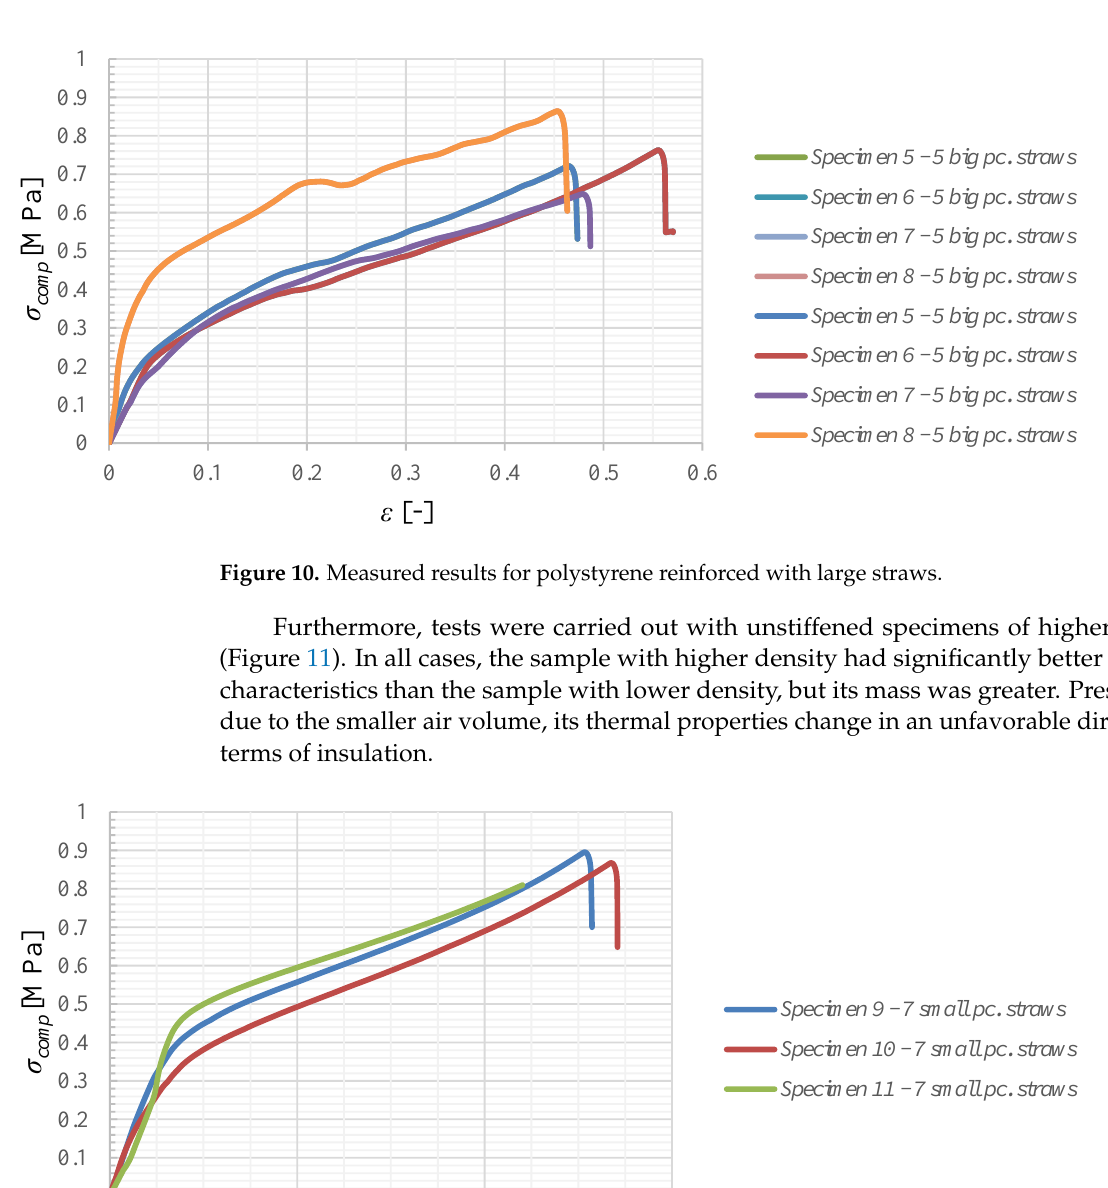
Figure 9. Measured results of normal and straw reinforced polystyrene.